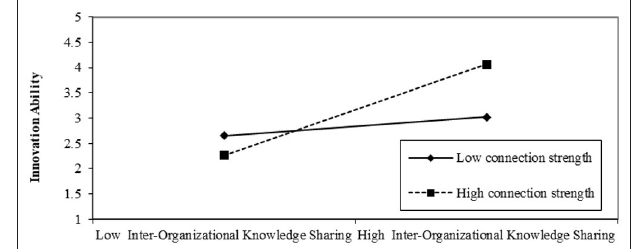
FIGURE 3 | Moderator effect test of network scale between inter-organizational knowledge-sharing and innovation